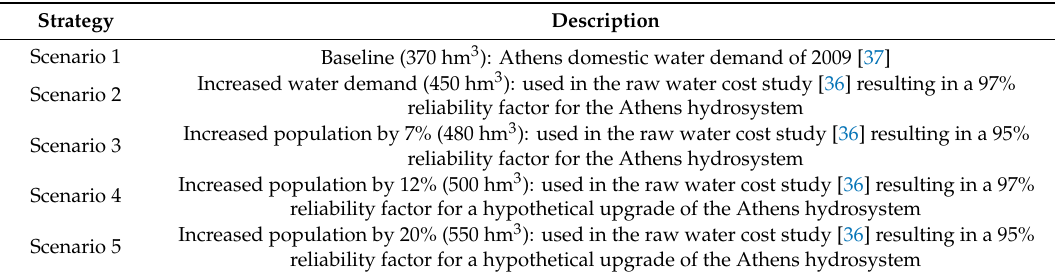
Table 2. Water demand scenarios under